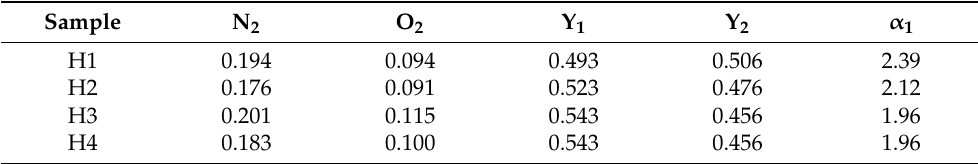
Table 6. Adsorption capacity (mmol/g) and selectivity coefficient ( α 1 ) in the zeolites studied at